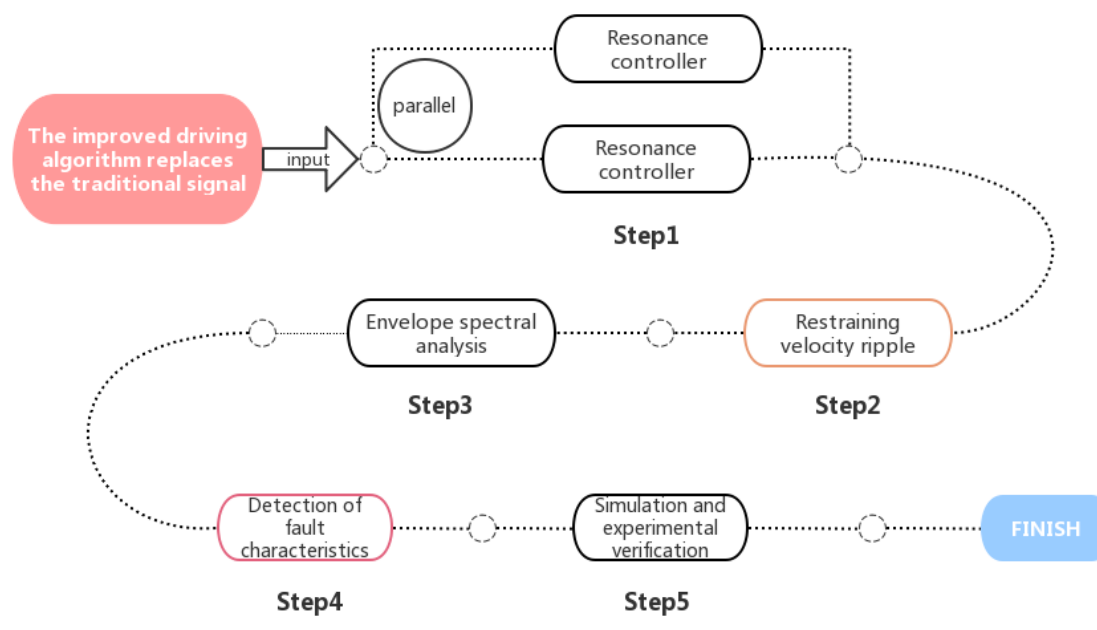
Figure 3. A comprehensive study of information theory measurement and intelligent tool fault detection led to a time-domain fault-feature-extraction method based on the mutual information between two phase current signals (Tiago et al., 2020) [57]. The flow of this method is shown in Figure 4.